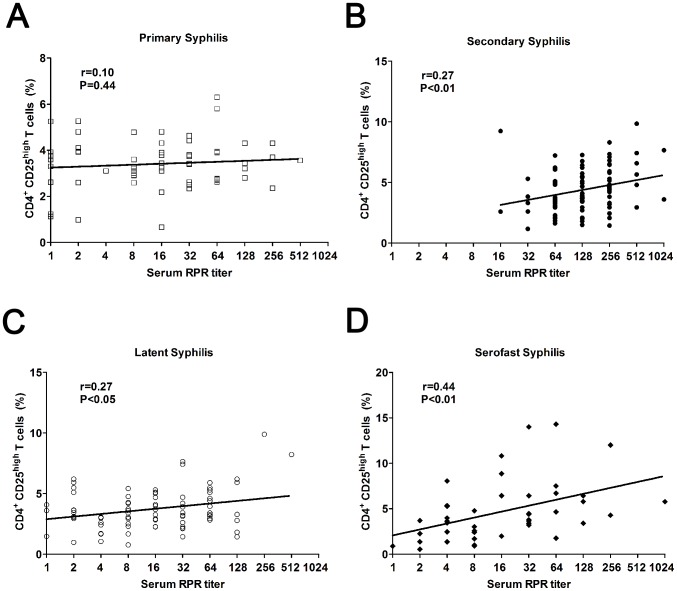
Association of circulating Treg numbers with serum RPR titers in primary, secondary, latent and serofast syphilis patients.Serum RPR titers are plotted against circulating CD4+ CD25high Treg frequencies in primary (A, n = 64), secondary (B, n = 96), latent (C, n = 86) and serofast (D, n = 43) syphilis patients. Each dot represents an individual patient. The straight line in each graph is the result of linear regression analysis. Pearson's correlation coefficients (r) and P values are shown.